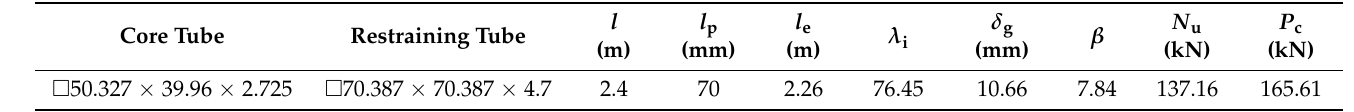
Table 1. Basic parameters of the specimen.